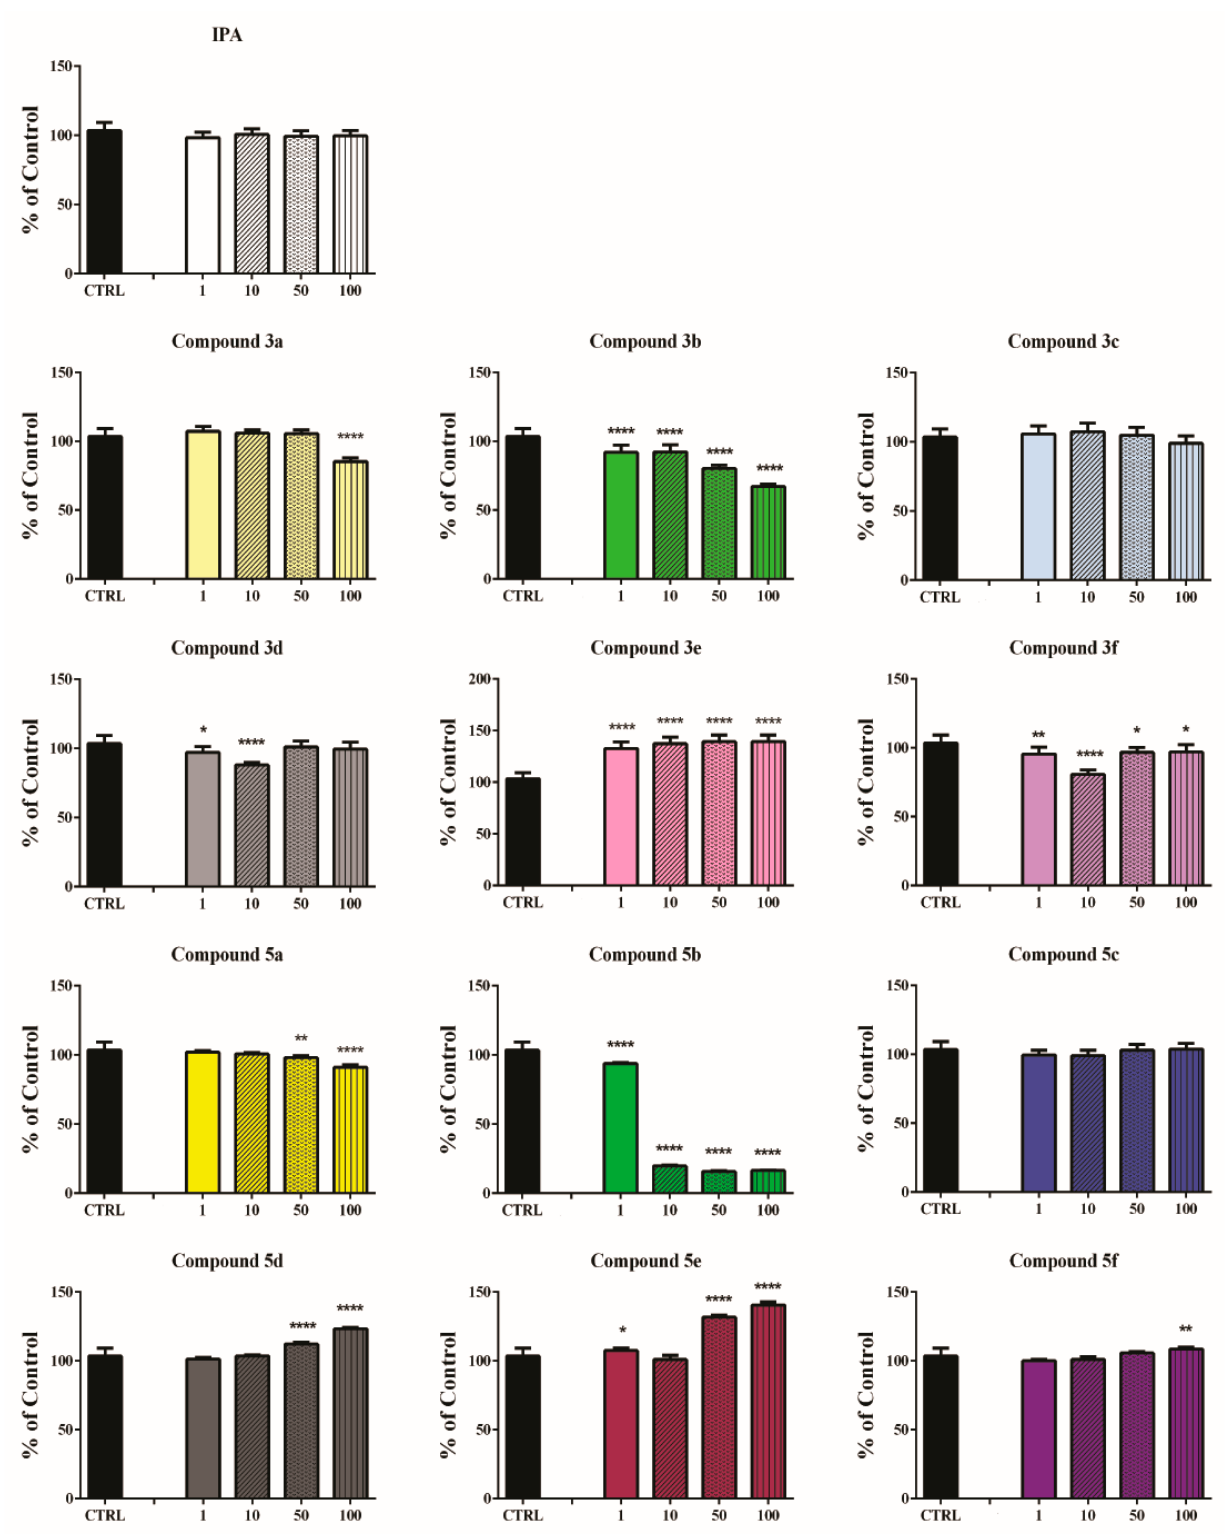
Figure 8. Superoxide-radical-scavenging activity assay in xanthine-oxidase model system. Data are presented as means ± SEM from three independent measurements. * p < 0.05, ** p < 0.01, **** p < 0.0001, vs. control. One-way analysis of variance with Dunnet’s post hoc test were used. In the presence of 3e , 5d , 5e, and 5f , we observed a statistically signi fi cant increase in the absorbance ratio parameter. In the samples containing 3e, the observed e ff ect was not